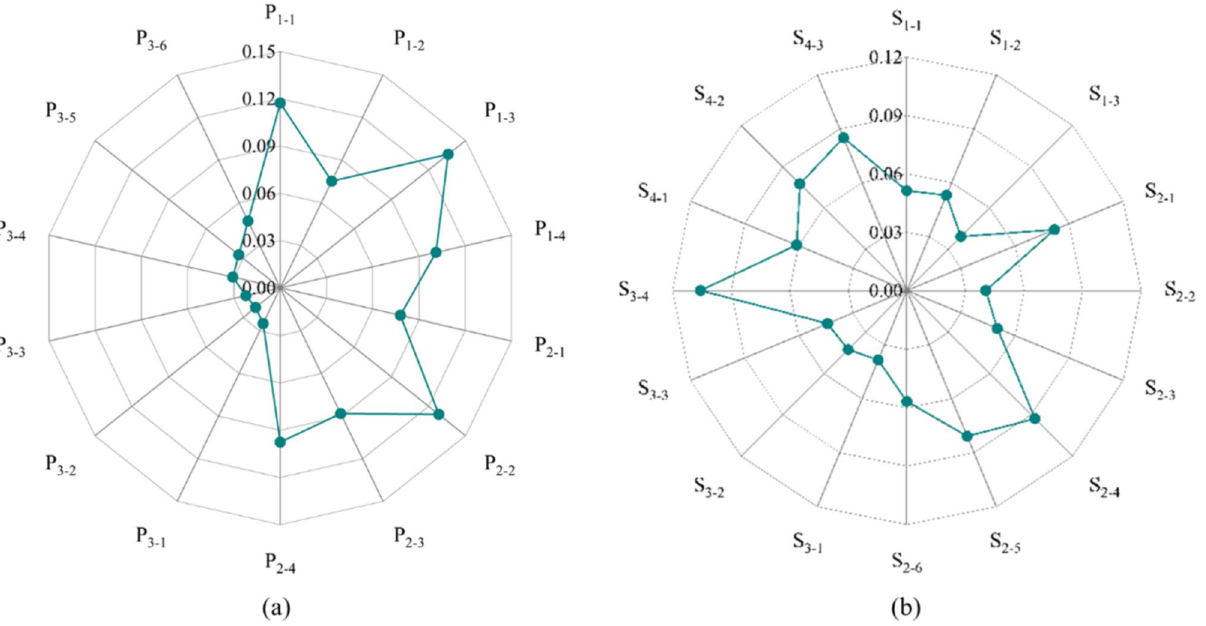
Figure 3. Comprehensive weights of evaluation indicators. ( a ) Pressure indicators weights; ( b ) Support indicators